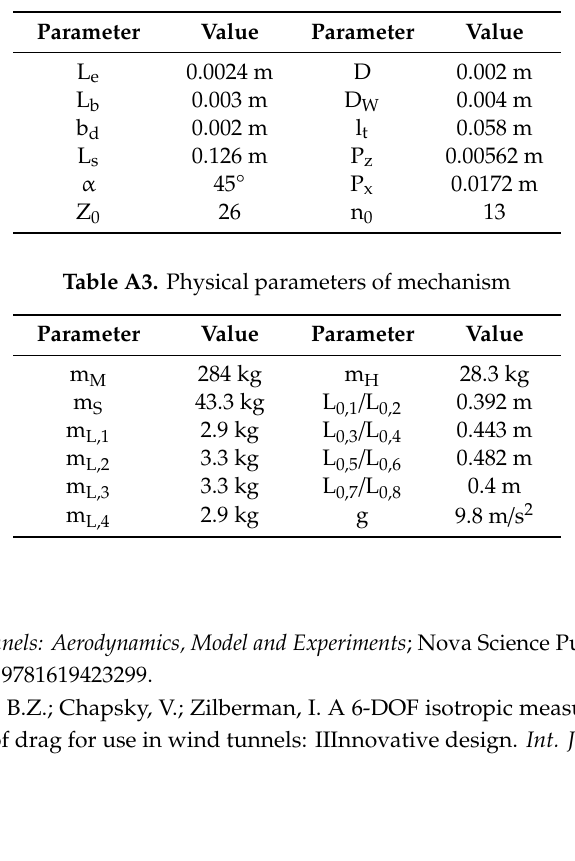
Table A2. Physical parameters of guideway.